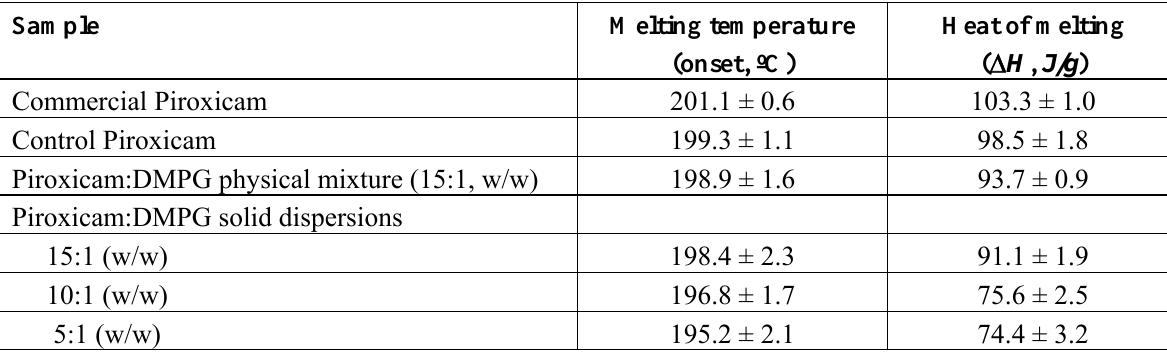
Table 2. Thermal characteristics of piroxicam and piroxicam-DMPG binary systems. Each point is the mean ± SD (n = 3).